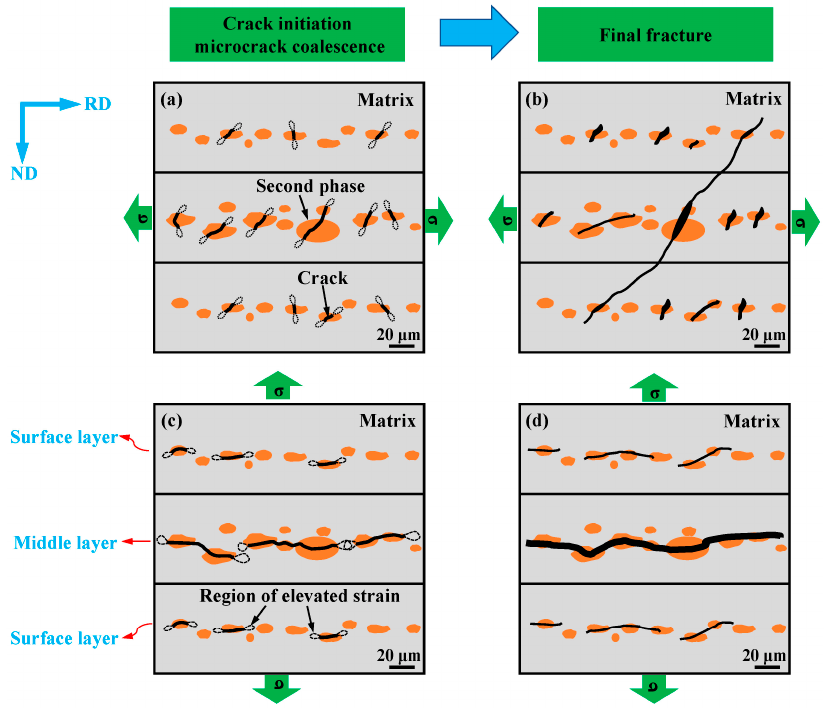
Figure 11. The schematic diagram of influence of the second phase on fracture process of the 2519A aluminum alloy: ( a , b ) RD load, ( c , d ) ND